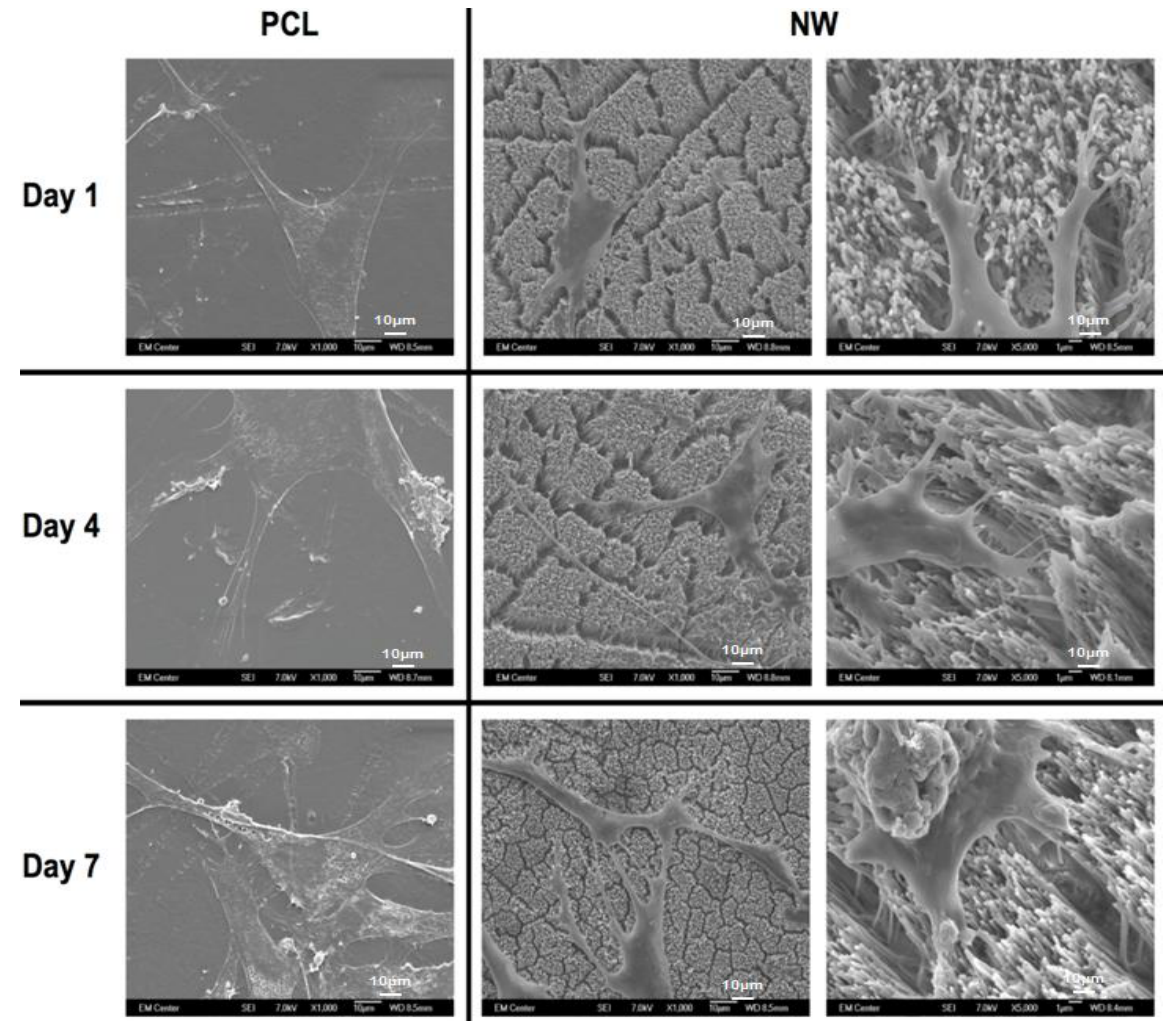
Figure 6. Representative SEM images of ADSCs on PCL and NW after 1, 4, and 7 days of culture. The high magnification images on NW show cell extensions and adhesion sites between the ADSCs and the individual